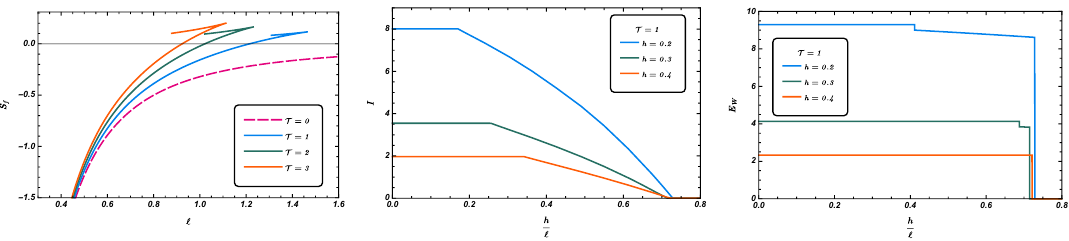
Figure 6 . Finite part of the HEE (left), HMI (middle) and EWCS (right) as functions of the width and separation between subregions for different values of T and h in d = 4